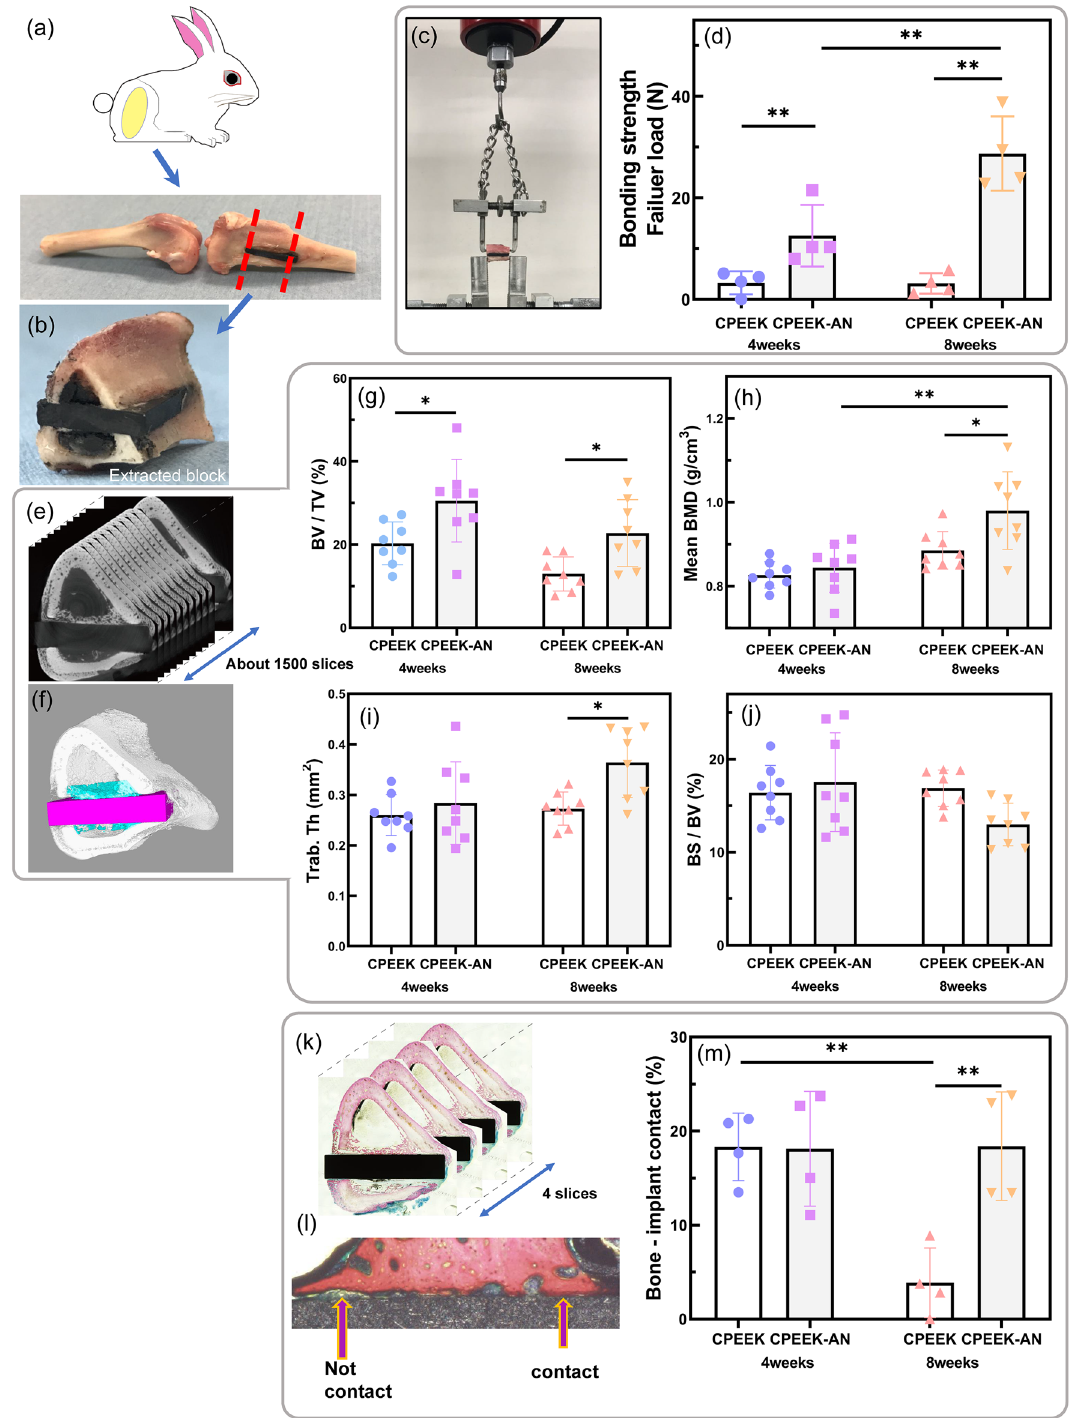
Figure 5. In vivo study. ( a ) Schematic illustration of a Japanese white rabbit and the removed femur and tibia bones which includes the substrate after sacrifice. ( b ) The extracted block, cut from the tibia bone, including a substrate. ( c ) The apparatus for the detaching test. ( d,e ) Reconstruction of a 3D model using around 1500 μ-CT image slices taken from the extracted block. 3D-model shows new bone (blue), within 1 mm on the surface of the substrate (purple). ( f ) An illustration depicting a region in contact vs the one not in contact. ( g ) Four histological slices taken from the block. ( h ) Bonding strength. ( i ) Bone volume/total volume (BV/TV, %), ( j ) mean bone mineral density (Mean BMD, g cm −3 ). ( k ) Trabecular thickness (Trab. Th, mm 2 ), and ( l ) bone surface/bone volume (BS/BV, %), based on ( d,e ) evaluation. ( m ) Bone-implant contact (BIC) ratio (%), based ( f ) quantification. The symbol ‘‘*” indicates p < 0.05 and ‘‘**” indicates p <